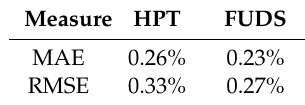
Table 3. Algorithmic performance on capacity estimation for the simulation study.